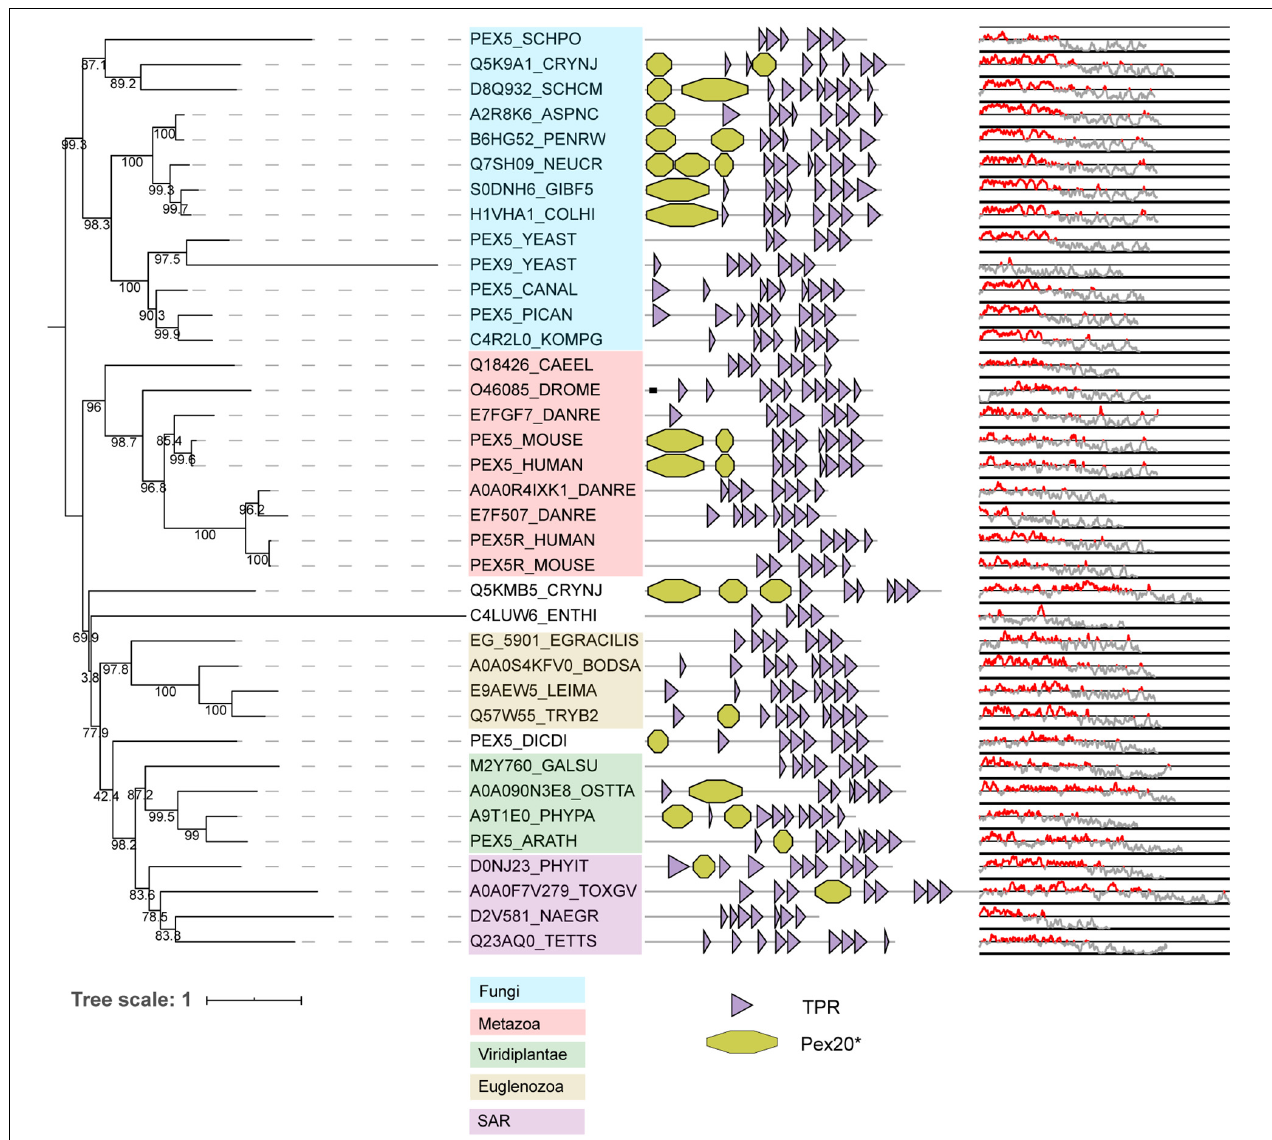
FIGURE 4 | Phylogeny and protein features of PEX5 orthologs. The phylogeny is rooted at mid-point to ease the visualization and labels of the main taxonomic groups are colored accordingly to the legend. Note that the topology does not necessarily reflect the actual evolutionary trajectory of such proteins. Protein domain architecture is defined by pfam annotations. The Pex20 ∗ is a manually generated hidden Markov model (CSM, this study). The line-dot plot indicates the regions predicted be disordered (red) and not disordered